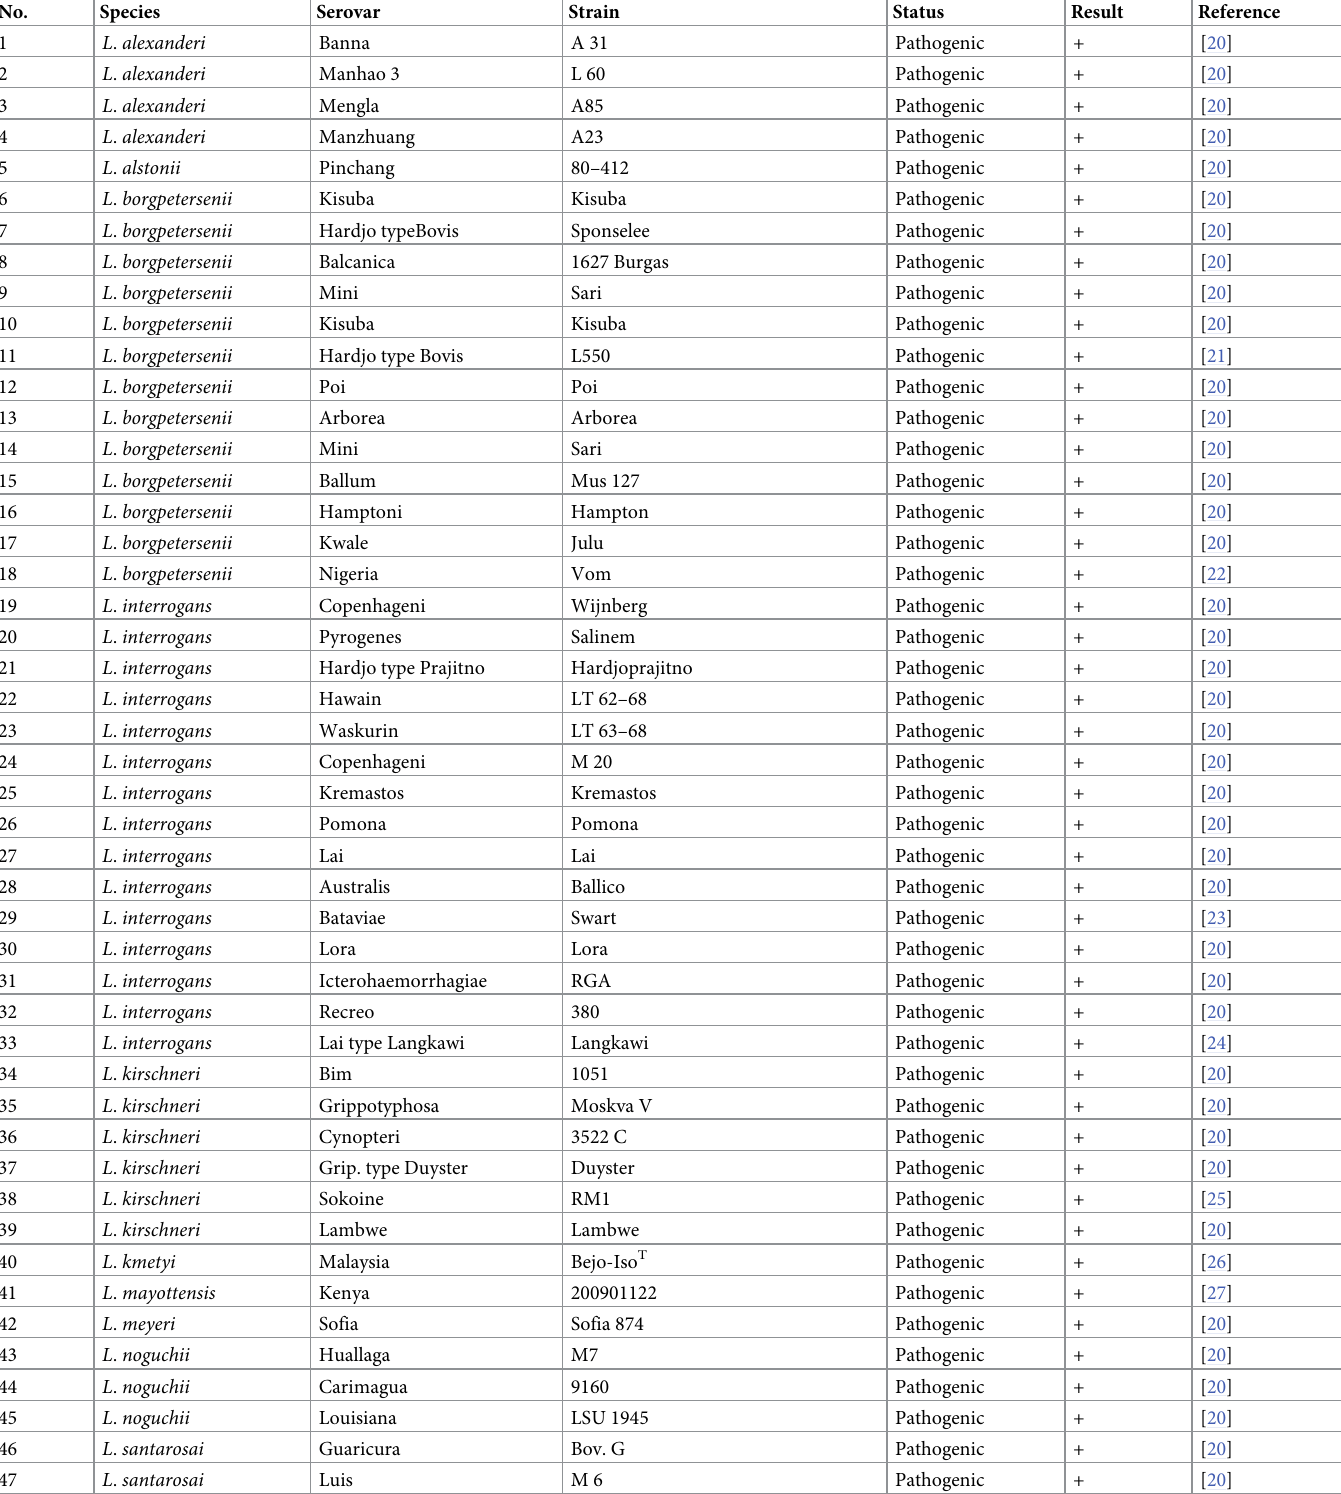
Table 1. Leptospira strains used in the assay.